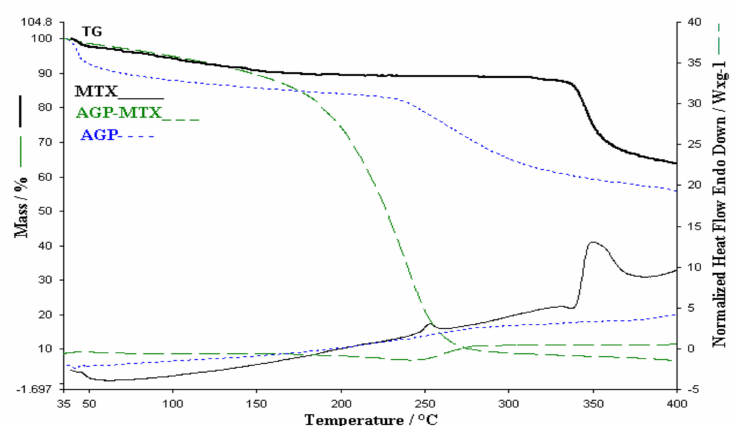
Figure 8. Comparative of TGA and HF for AGP membrane, AGP-MTX and MTX.